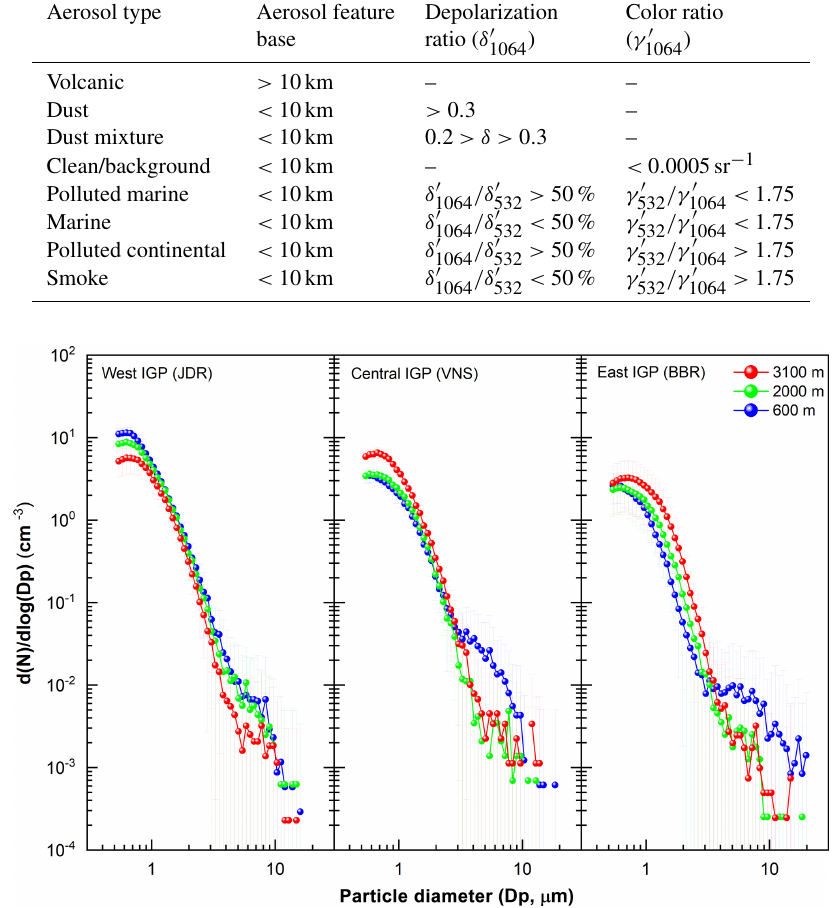
Figure 3. Aerosol number size distributions (mean profiles averaged for all the days) at three distinct altitudes of JDR, VNS and BBR, representative of (i) near the surface (600ma.g.l.) having proximity to emission sources, (ii) the upper ABL (2000ma.g.l.) and (iii) the free troposphere (3100m). Vertical bars over the points are the ensemble standard deviations. Individual size distributions at different heights of ∼ 500m intervals are given in Fig. S1 in the